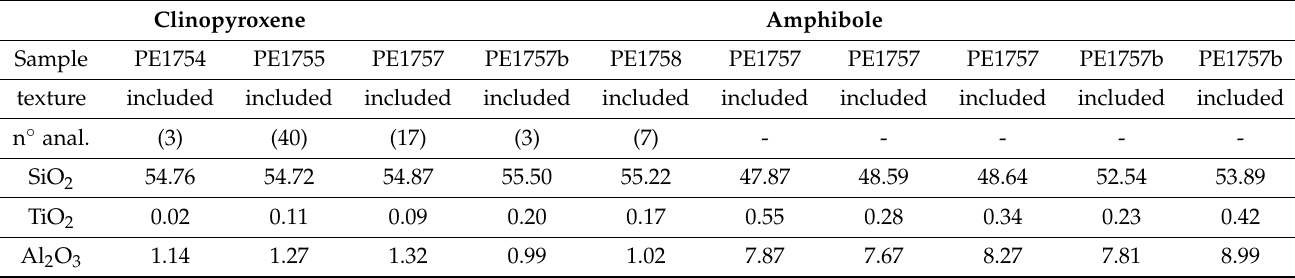
Figure 7. Compositional variations of olivine inclusions in chromite define trends of decreasing forsterite and NiO wt% from Prospect 33 (KR-33) to Bolshoi Bashart (KR-BB), reflecting differentiation of the chromite parent melt during ascent to the mantle/crust transition zone. The same trend is visible in olivine inclusions in the chromitites of the other chromite deposits of the Urals: Alapaevsk (AL), Kluchevskoy (KL), Kempirsai (KP), and Ray-Iz (RZ) (data from [12,14,27]). The field of olivine from the Kraka mantle lherzolite (Lz) and harzburgite (Hz) is shown for comparison. The clinopyroxene in chromitite 33 (Table 3) corresponds to the composition of diop- roxene from mantle chromitites of the Urals (Figure 8A,B). Solitary inclusions of amphibole were not encountered. Notably, the amphibole occurring in composite inclusions of chromi- tite 33 (Table 3) has higher Na content at a given Al/Si, compared with the amphibole from the Kempirsai chromitites (Figure 8C,D). Table 3. Electron microprobe compositions (wt%) of clinopyroxene and amphibole inclusions in chromite of Prospect 33 from the Kraka mantle